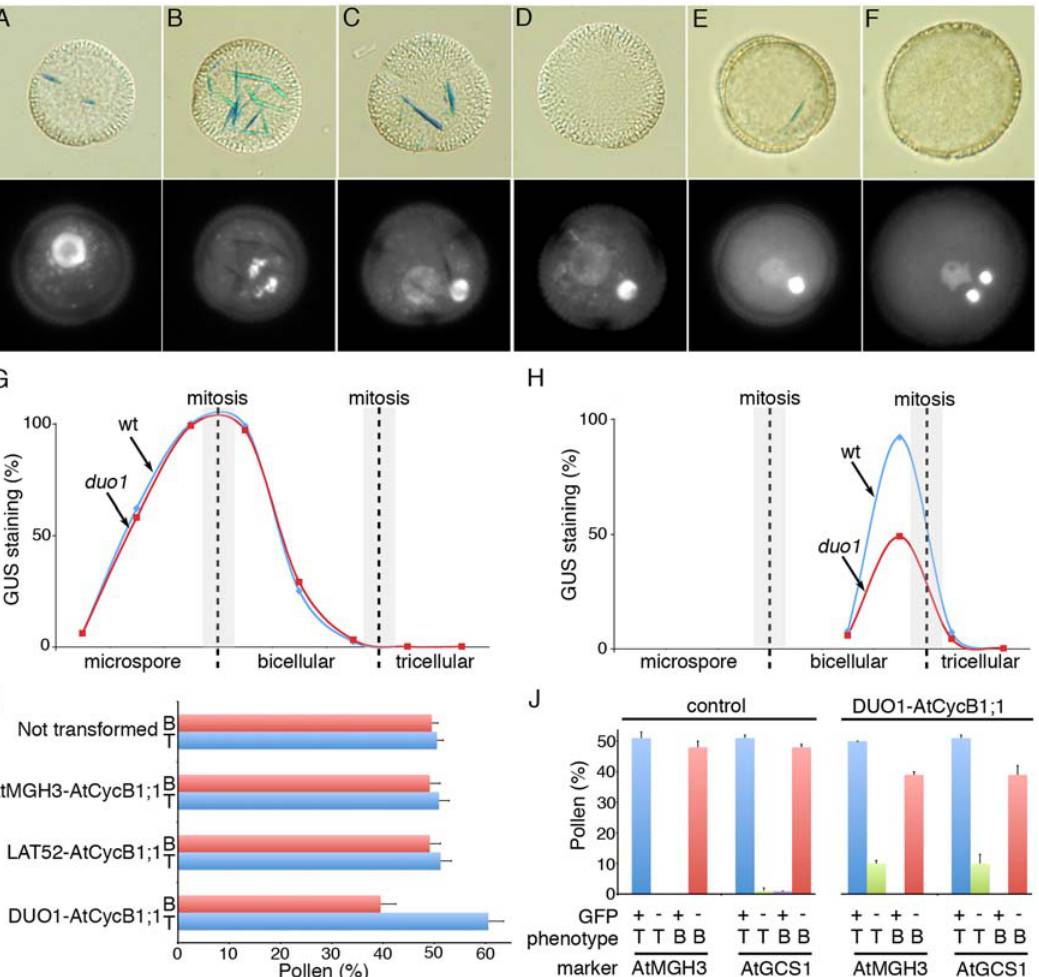
Figure 3. AtCycB1;1 expression in developing pollen. (A–F), pCDG-dependent GUS staining (upper panel) and DAPI staining (lower panel) in isolated spores: (A, B), unicellular microspores, (C, D, E), early, mid-and late bicellular pollen and (F), tricellular pollen. (G, H) The frequency of pCDG- dependent GUS staining in microspores and vegetative cells close to mitosis is similar in duo1 heterozygotes and wild type plants (G), whereas GUS staining in germ cells, is reduced by approximately half in duo1 heterozygotes, where 50% of the pollen is WT and the other 50% mutant (H). The stage of pollen development is indicated below each graph and the approximate time of mitosis is indicated by grey squares with a dashed line. (I) DUO1-AtCycB1;1 is able to partially complement the bicellular phenotype of duo1 pollen. The amount of tricellular pollen (T) increases and the amount of bicellular pollen (B) decreases when heterozygous duo1 plants are transformed with DUO1-AtCycB1;1 (n=31 T1 lines) compared with plants either not transformed (n=3 individuals) or transformed with control constructs AtMGH3-AtCycB1;1::GFP (n=17 T1 lines) or LAT52-AtCycB1;1 (n=17 T1 lines). Bars represent the average percentage of pollen with error bars showing standard deviation. (J) Germline markers are not activated in the complemented tricellular pollen. In non-complemented plants , 50% of the pollen is tricellular (T) with marker expression and , 50% is bicellular (B) without marker expression. When the bicellular phenotype is partially complemented by DUO1-AtCycB1;1, , 10% of pollen is tricellular without marker expression, while there is a decrease in the amount of bicellular pollen. Bars represent the average percentage of pollen from 3–6 individual plants with the error bars showing standard deviation.